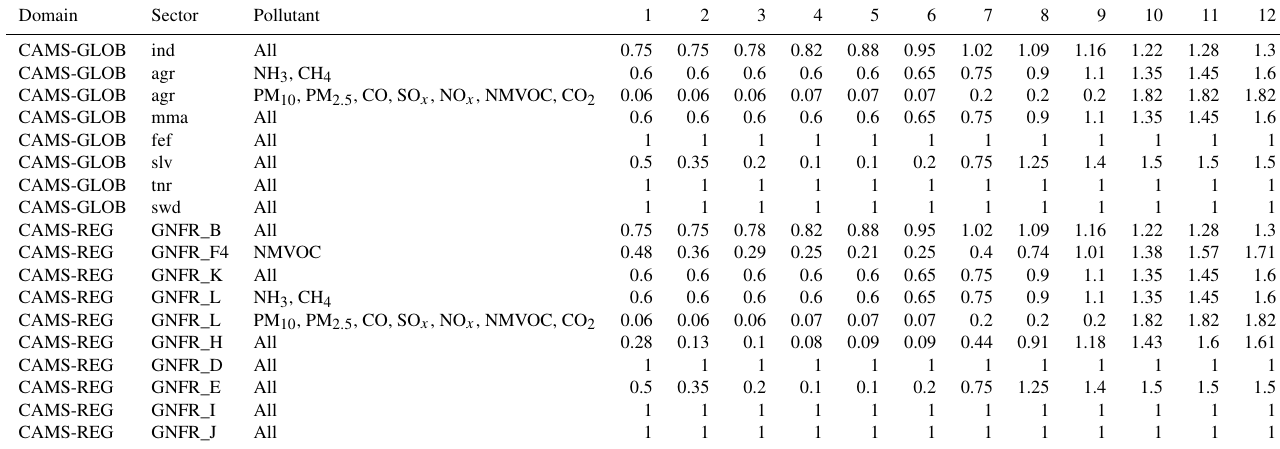
Table A3. Fixed hourly temporal profiles per domain, sector and pollutant (part 1: 00:00–01:00 to 11:00–12:00). The definition of the sectors can be found in Tables 2 and 3.